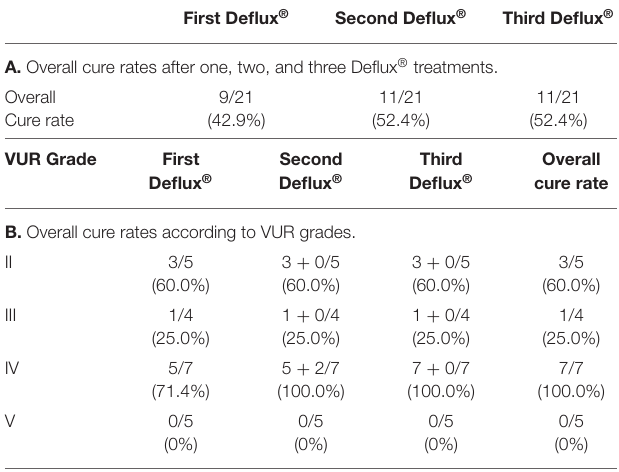
TABLE 1 | Resolution of vesicoureteral reflux (VUR) per ureter after Deflux ® . First Deflux ® Second Deflux ® Third Deflux ® A. Overall cure rates after one, two, and three Deflux ® treatments.